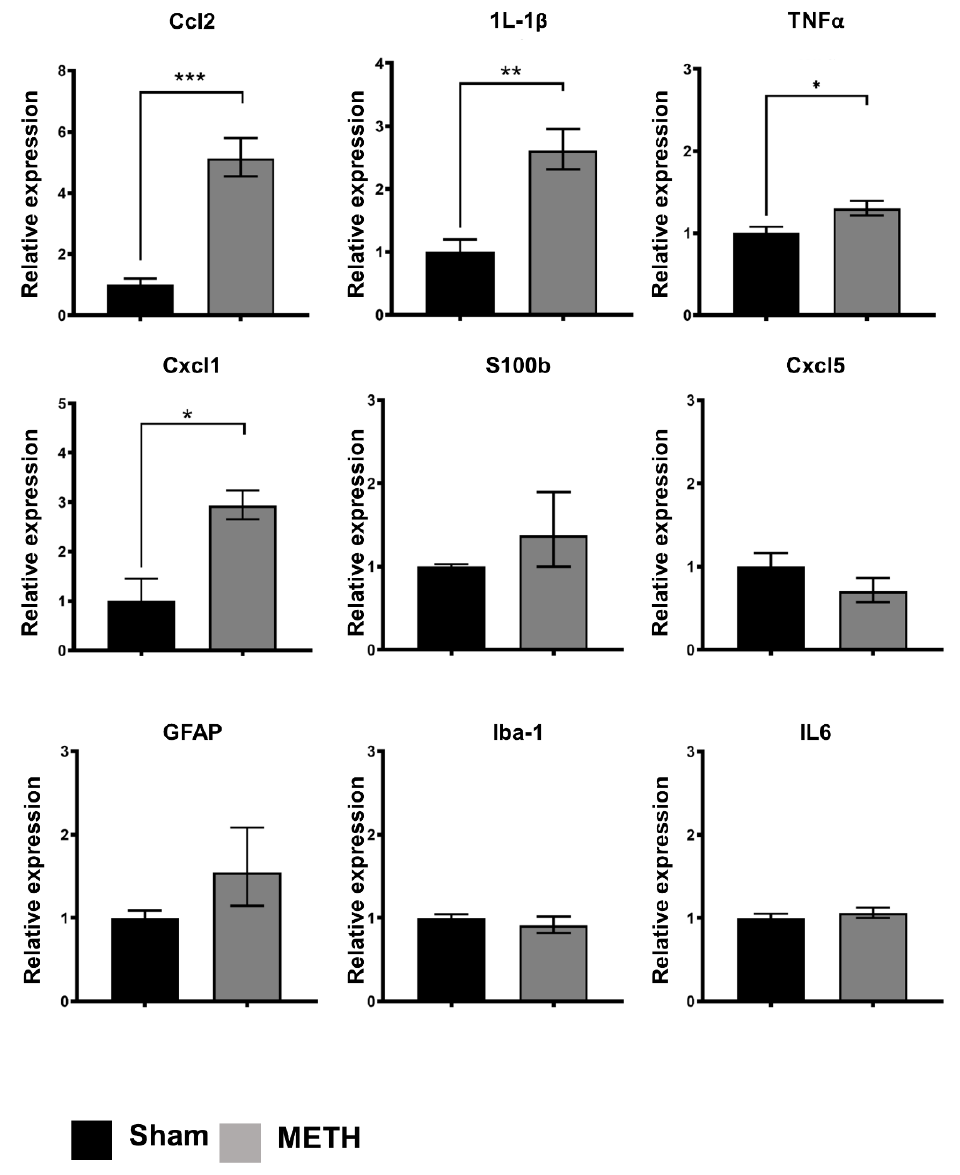
Figure 6. Acute METH exposure induces expression of pro-inflammatory markers in the mid-brain. Pro-inflammatory, chemokine, and glial cell markers expression in the brain. Expression of pro- inflammatory cytokines (IL- 1β, TNFα, and IL -6), chemokines (Cxcl1, Ccl2, and Cxcl5), and glial cell markers (GFAP, Iba-1, and S100b) were determined by real-time polymerase chain reaction (RT-PCR) in brain samples for sham- and METH-treated mice. Values are folding increase ± standard error of the mean (SEM) concerning the mean of controls, *** p < 0.005, ** p < 0.01, * p < 0.05.